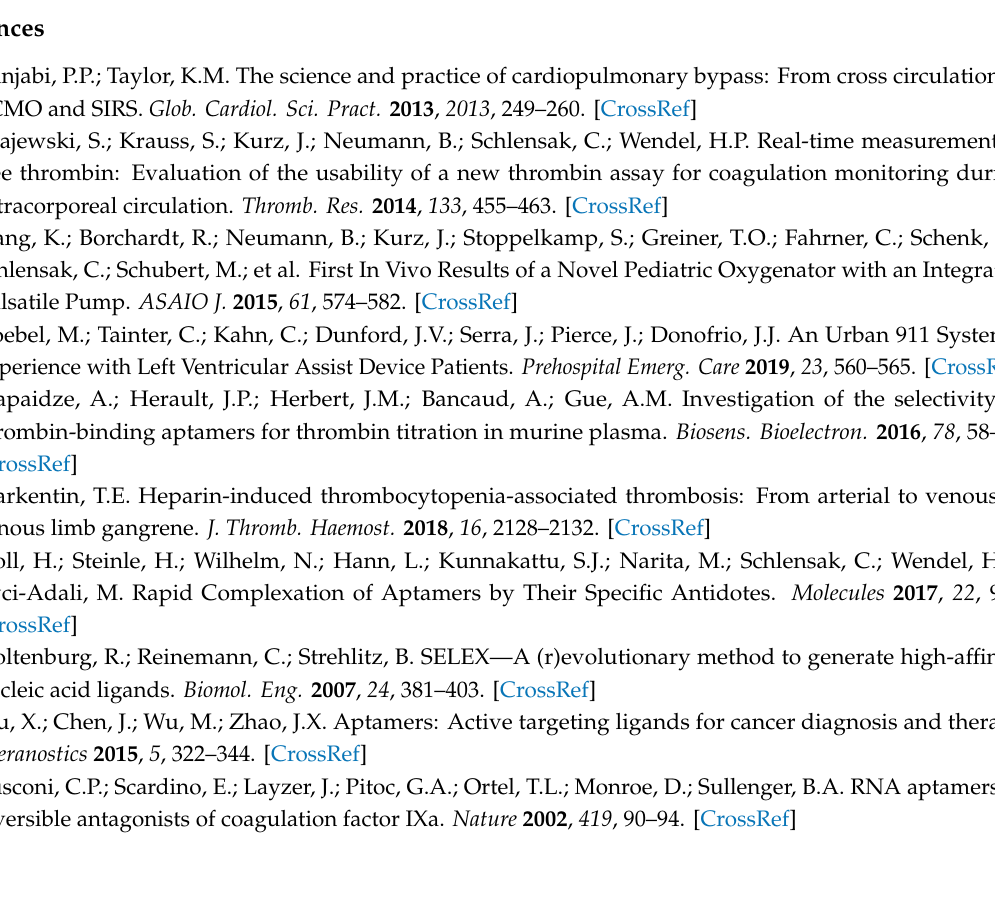
NU172. ( a ) Detection of mean viscous ( η (cid:48) ) and elastic ( η ”) components of blood at 100 Hz and 37 ◦ C (n = 5 ± SD). ( b ) Enlarged parts of diagrams for the calculation of CT. The horizontal dotted blue line at 0.002 Pa · s visualizes the η (cid:48) and the dashed red line at 0.0008 Pa · s visualizes the η ” of unactivated citrated blood. Table S1: Citrated blood was incubated with NaCl or various concentrations of NU172 aptamer, AD, or NS_AD for 2 min. Afterwards, the coagulation was activated by pathromtin and CaCl 2 (n = 10) and measured with PIEZ and KC 1A. Using PIEZ, the clotting time (CT), viscous ( η (cid:48) ) and elastic ( η ”) components at 300 s, and linear slopes (m( η (cid:48) ) and m( η ”)) were measured. Table S2: Citrated blood was incubated with NaCl or various concentrations of NU172 aptamer for 2 min. Then, 1.0 µ M AD was added and after 5 min the blood samples were activated with pathromtin and CaCl 2 . (n = 5). The measurement was performed with PIEZ and KC 1A. Using PIEZ, the clotting time (CT), viscous ( η (cid:48) ) and elastic ( η ”) components at 300 s, and linear slopes (m( η (cid:48) ) and m( η ”)) were measured. Table S3: Heparinized blood was incubated with NaCl, NU172 aptamer, NS_AD, or AD. After 2 min of incubation, the coagulation was activated with plasma cephalin and factor X a . (n = 10). The measurement was performed with PIEZ and KC 1A. Using PIEZ, the clotting time (CT), viscous ( η (cid:48) ) and elastic ( η ”) components at 300 s, and linear slopes (m( η (cid:48) ) and m( η ”)) were measured. Table S4: Heparinized blood was incubated for 2 min with 1.0 µ M NU172, then 1.0 µ M AD was added to the NU172 aptamer containing blood and incubated for 5 min. The clotting time (CT) was determined before and after the circulation for 30 min at 37 ◦ C in an in vitro rotation model using PIEZ or KC 1A. Blood without any additives was indicated as a baseline. Blood with NaCl, 1.0 µ M NS_AD, or AD were used as negative controls. Blood with 1.0 µ M NU172 served as positive control. Blood from five di ff erent volunteers was used (n = 5 ± SD). Using PIEZ, the clotting time (CT), viscous ( η (cid:48) ) and elastic ( η ”) components at 300 s, and linear slopes (m( η (cid:48) ) and m( η ”)) were